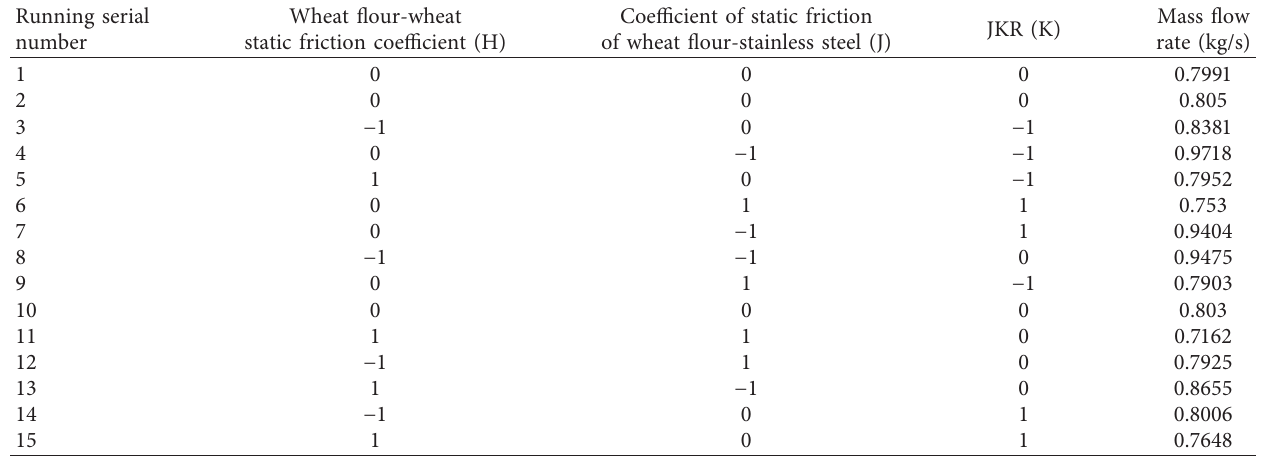
Table 6: Design and results of Box-Behnken experiment.